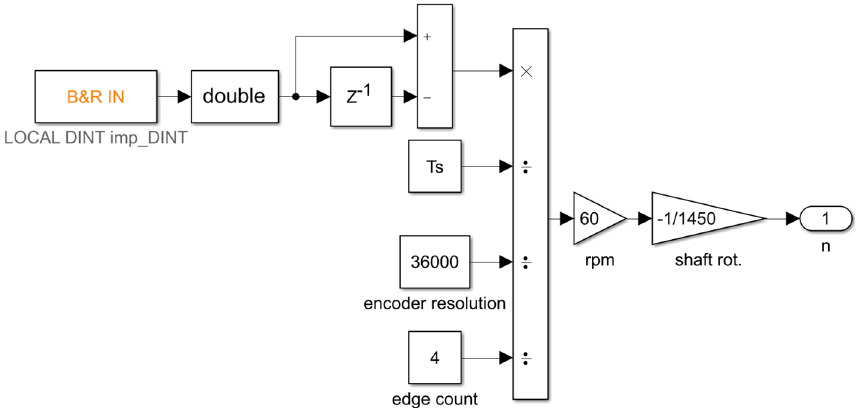
Figure 5. Speed calculation algorithm.